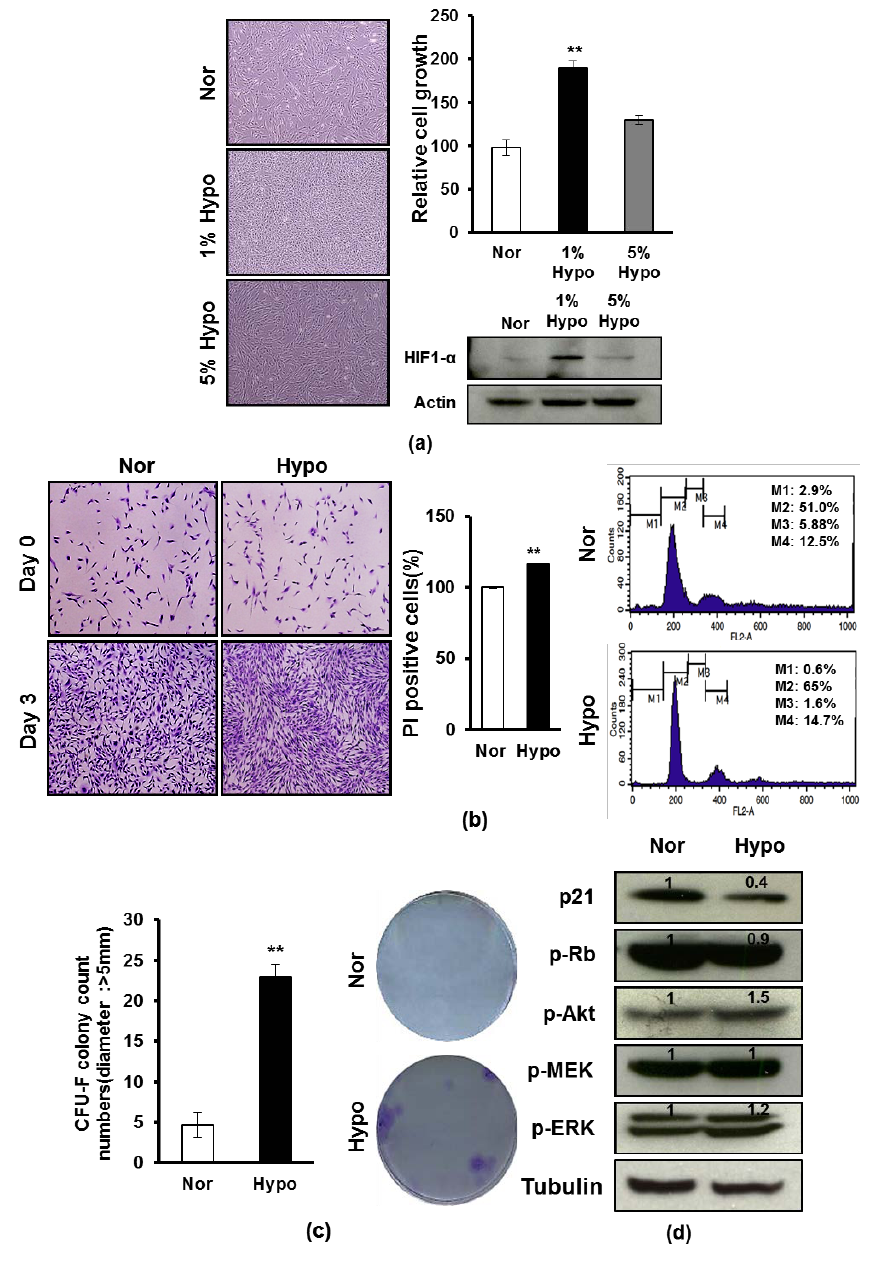
Figure 1. The Effect of hypoxia on the proliferation and survival of AF-MSCs. ( a ) AF-MSCs were cultured under normoxic or hypoxic conditions (1% or 5% O 3 days, showing different growth and expressing different protein levels of HIF1-α at protein levels. All cells were stained by 0.01% crystal violet. The graph shows the relative cell growth; ( b ) PI-stained AF-MSCs that were cultured under normoxic or hypoxic condition (1% O ) after 3 days, showing the increase of the number of PI-stained cells in the G1phase 2 of cell cycle in responses to hypoxic condition. (M1: apoptotic cells; M2: G1; M3: S; M4: G2/M); ( c ) CFU-assay of AF-MSCs cultured under normoxic and hypoxic condition showed that the clonogenic capacity of AF-MSCs increased under hypoxic condition compared to normoxic condition; and ( d ) AF-MSCs under hypoxic condition express different protein levels of cell proliferation- or survival-related regulators (P21, p-Rb, p-Akt, p-MEK and p-ERK). Data are expressed as the mean ± SD. ** p <